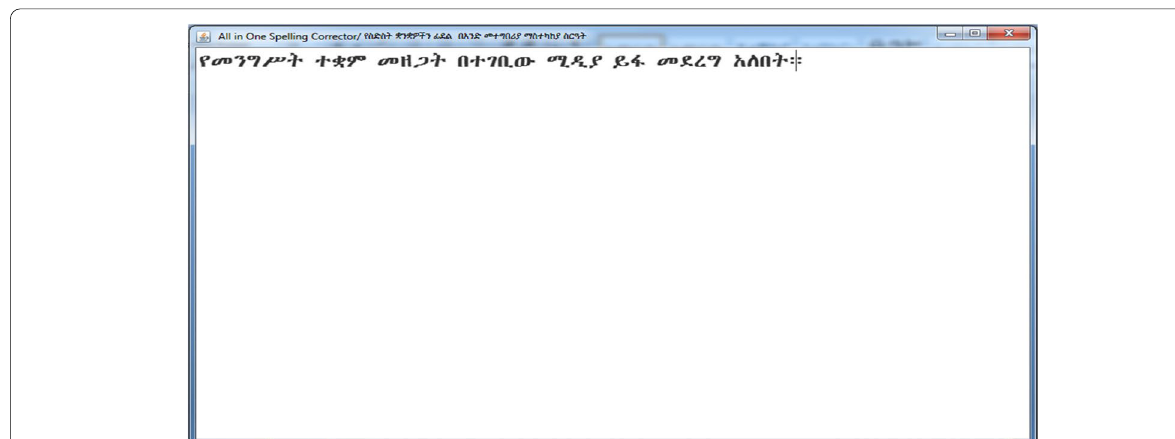
Fig. 6 Sample GUI for words that are free from any spelling error